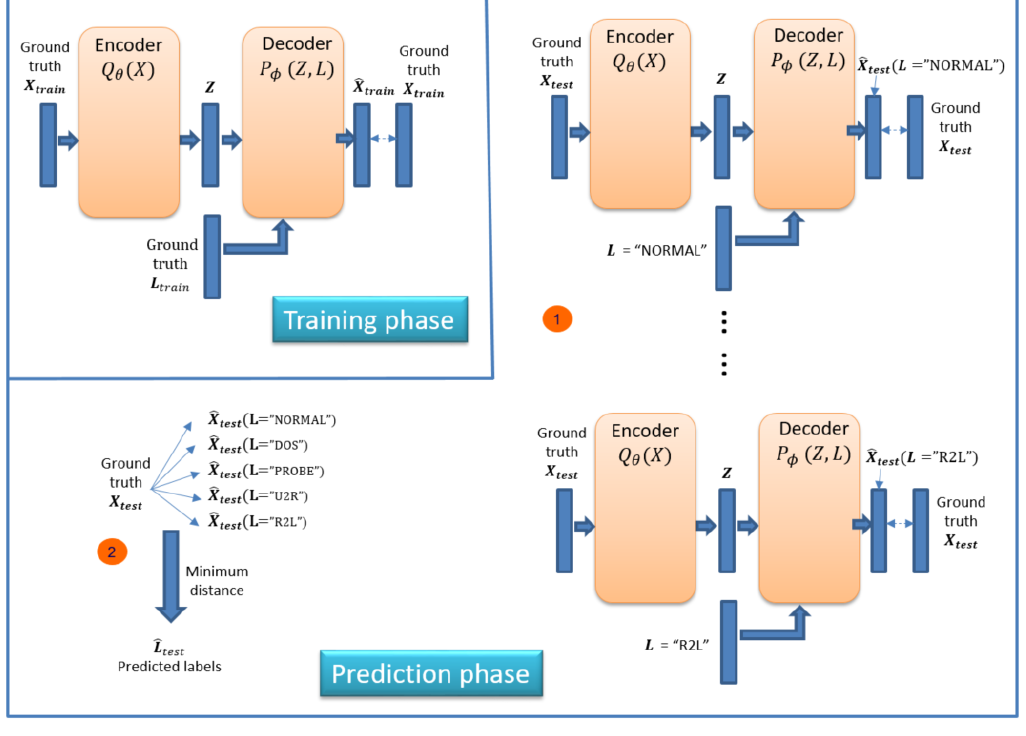
Figure 4. Classification framework.